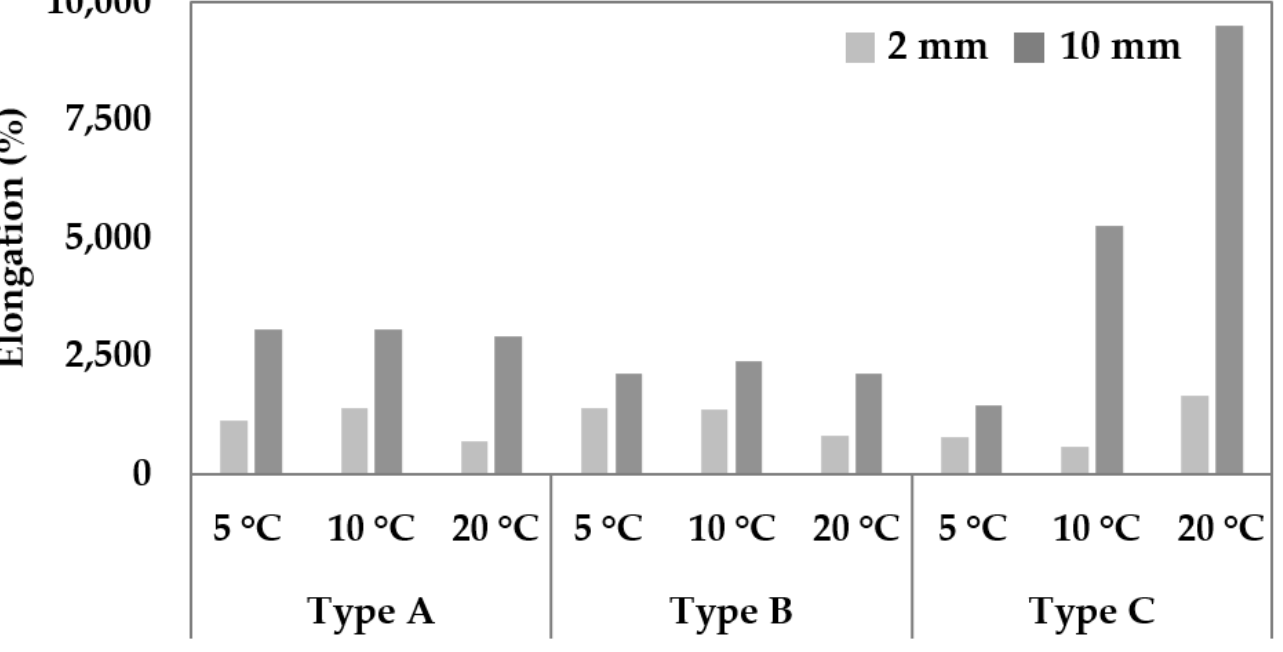
Figure 11. Elongation comparison according to thickness and temperature.